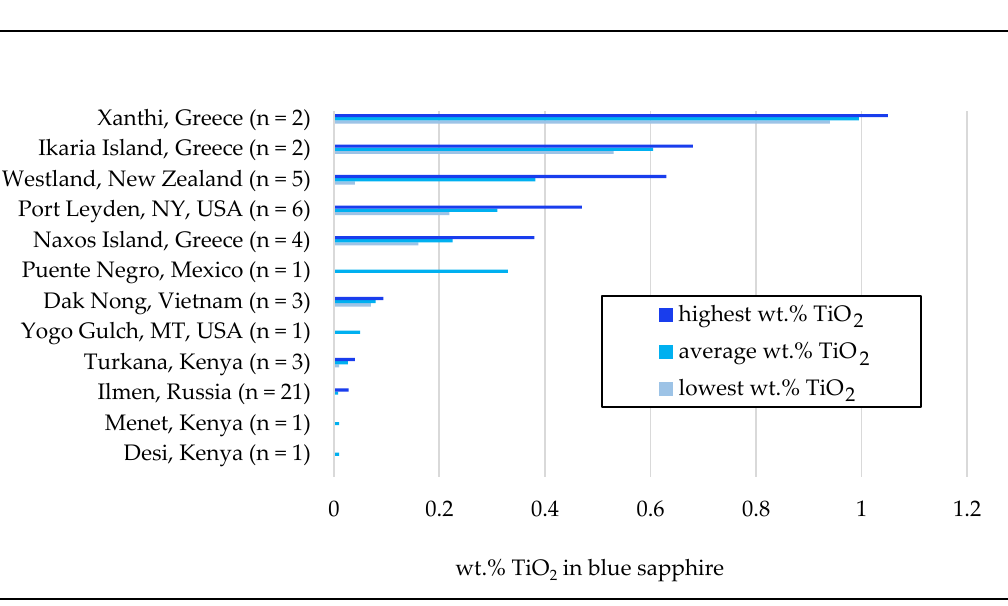
Figure 6. Bar graph showing wt. % TiO 2 in sapphires from Xanthi, Greece [18], Ikaria Island, Greece [18], Westland, New Zealand [19], Port Leyden, NY, USA (this study); Naxos Island, Greece [18], Puente Negro, Mexico [3], Dak Nong, Vietnam [20], Yogo Gulch, MT, USA [21], and Desi-Menet-Turkana, Kenya [22], and Ilmen, Russia